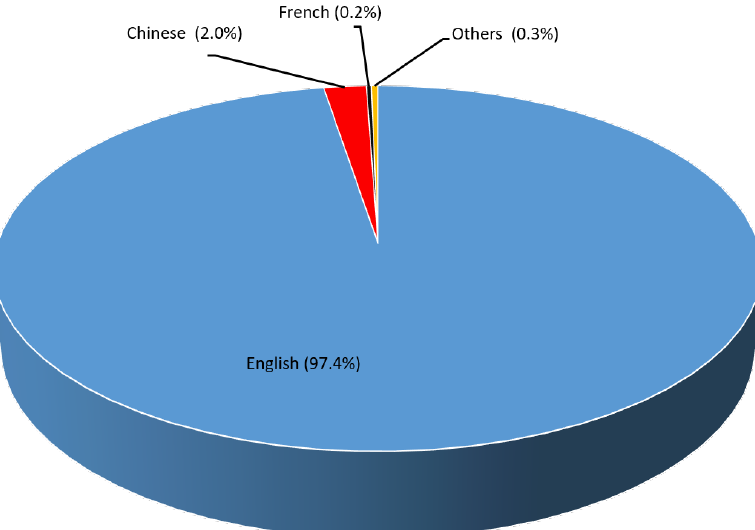
Figure 1. Distribution of retrieved articles on fractal theory in thin film materials by language. It can be seen that most of the articles in the topic are written in English.